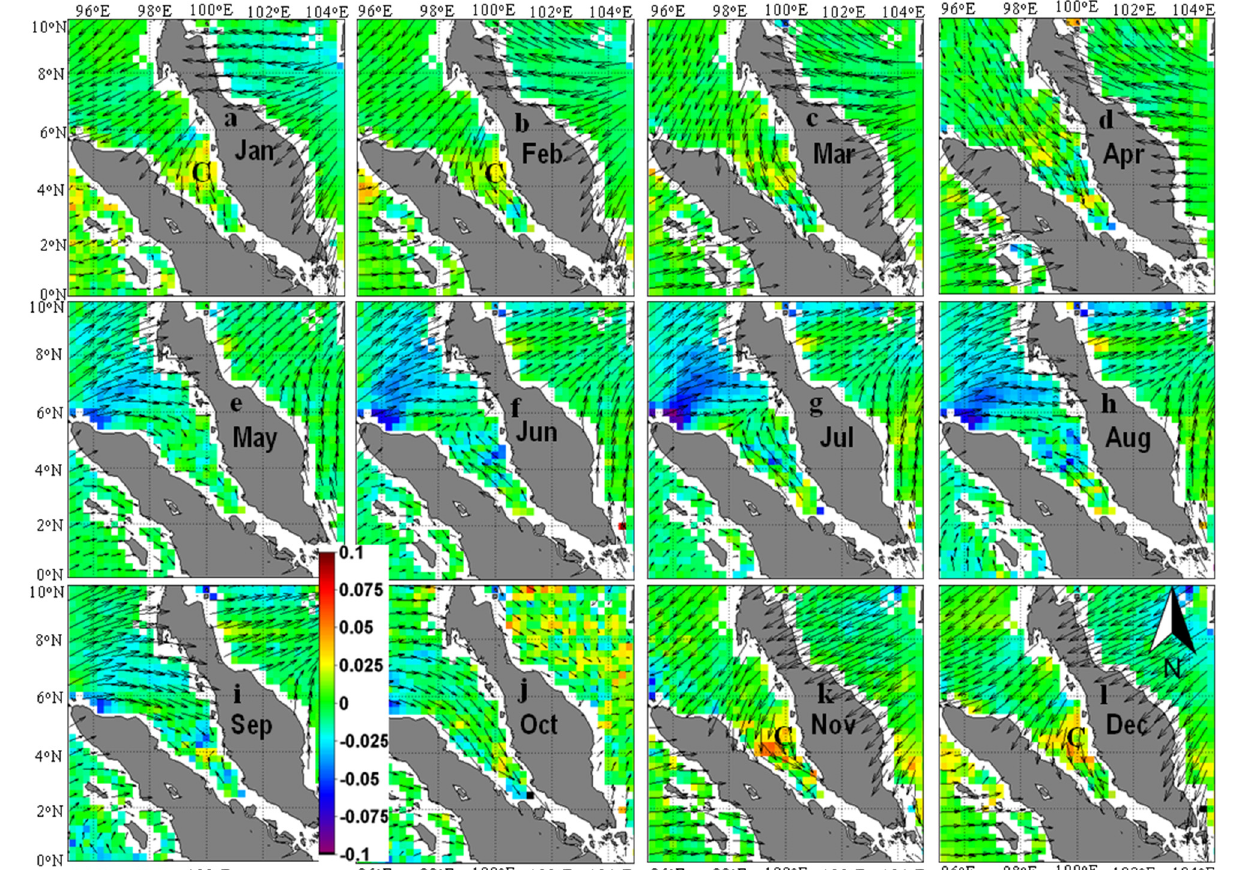
Figure 12. ( a – l ) Monthly climatological means of upwelling (positive wind stress curl) and downwelling (negative wind stress curl) evidenced by monthly climatological means of wind stress curl (Pa∙m −1 , color scale) averaged from monthly QuikScat wind field data retrieved within the period of the SeaWiFS mission. Monthly climatological means of QuikScat wind field data are also shown. The letter C in ( a , b , k , l ) has the same meaning